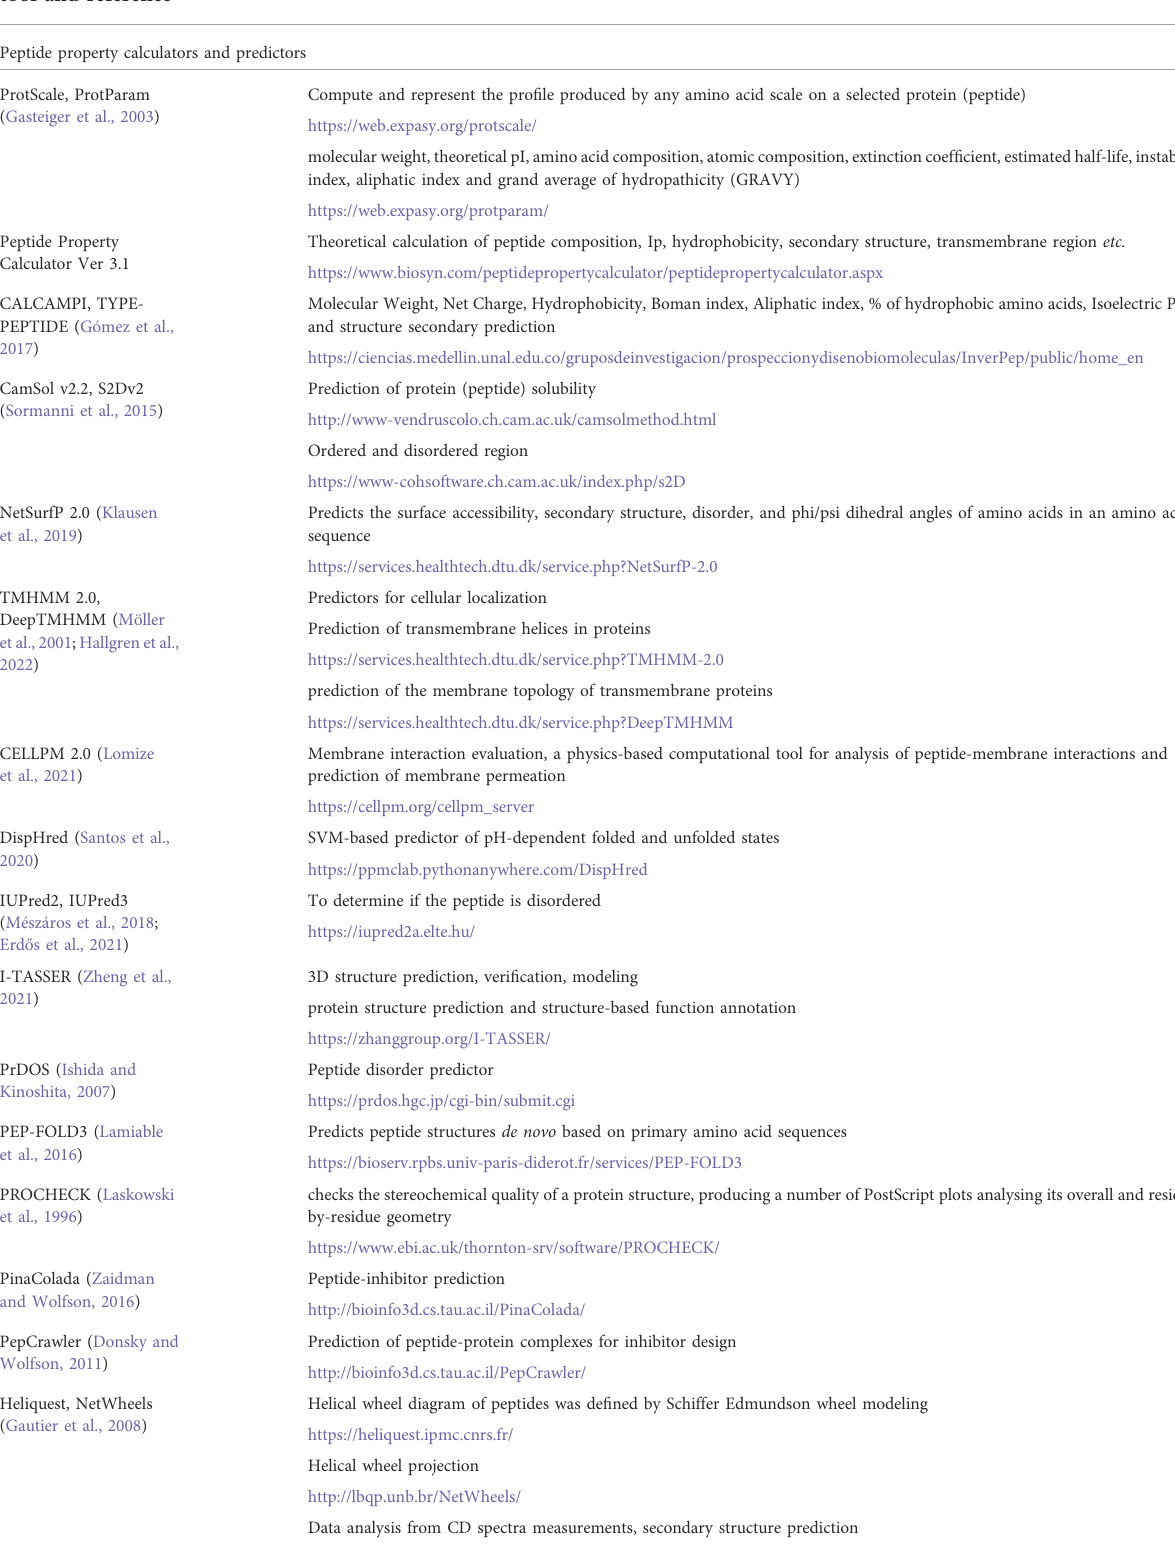
TABLE 1 Online databases and tools to predict and characterize CPPs, bioactive CPPs and CPP-cargo. Server/predictor/ tool and